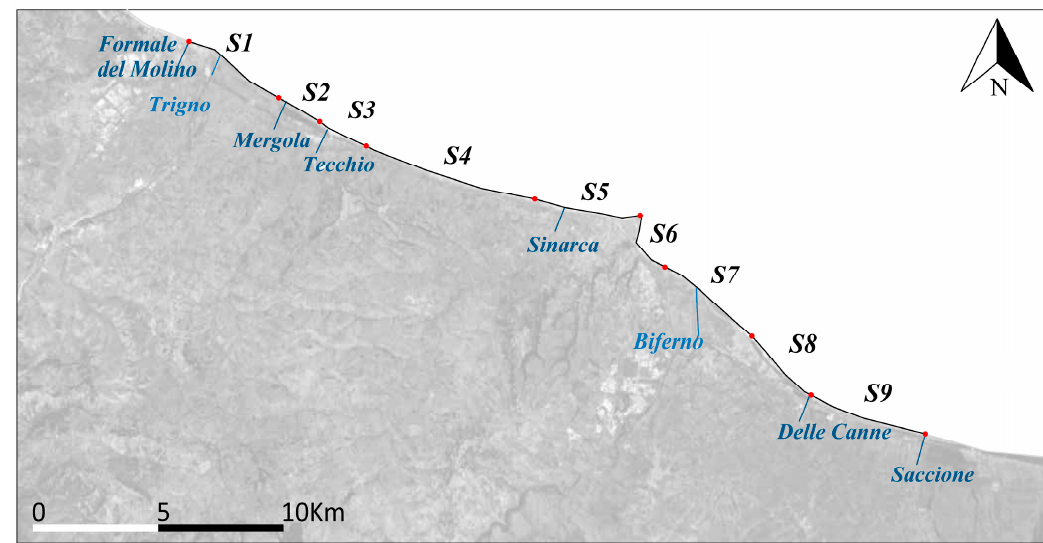
Figure 3. Studied coastal cells along the Molise coast and location of the main rivers.